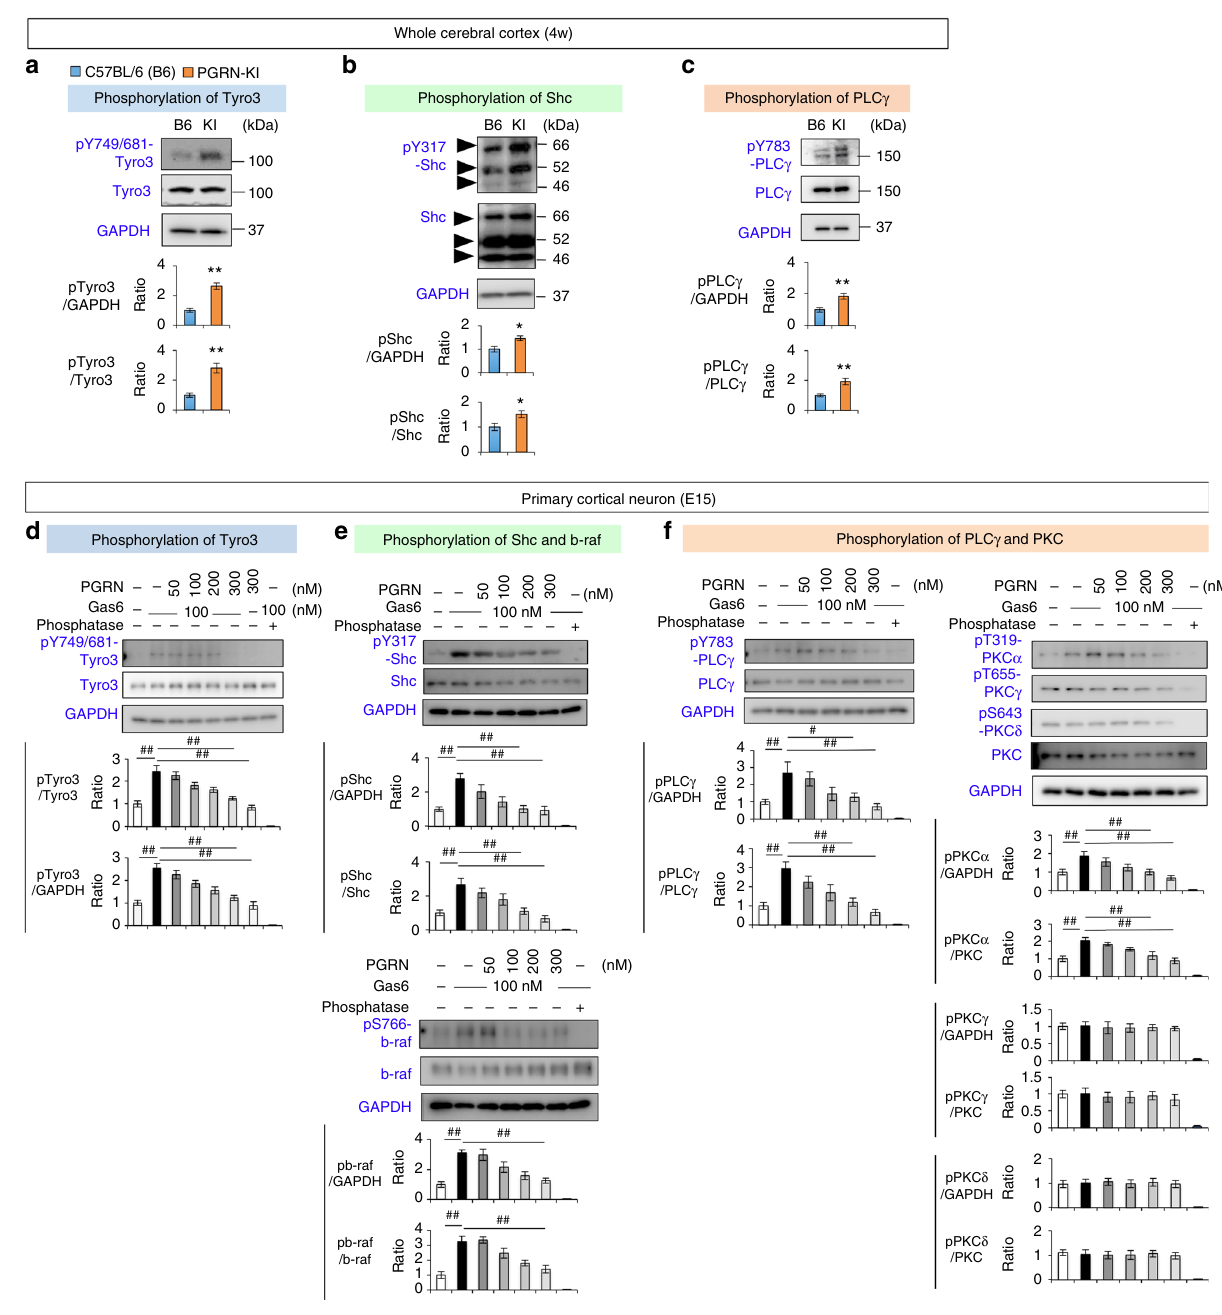
Fig. 3 PGRN inhibits downstream signals of Tyro3. a Western blot analyses show elevated phosphorylation of Tyro3 in the whole cerebral cortex sample prepared from PGRN-KI mice. Lower graphs show quantitation of pTyro3/GAPDH and pTyro3/Tyro3 ratios. * p < 0.05; ** p < 0.01 ( N = 6, Student ’ s t -test). Averages and s.e.m. are shown. b Western blot analyses show elevated phosphorylation of Shc was elevated in cerebral cortex of PGRN-KI mice. * p < 0.05; ** p < 0.01 ( N = 6, Student ’ s t -test). Averages and s.e.m. are shown. c Western blot analyses show elevated phosphorylation of PLC γ is increased in cerebral cortex of PGRN-KI mice. * p < 0.05; ** p < 0.01 ( N = 6, Student ’ s t -test). Averages and s.e.m. are shown. d Western blot analyses of Tyro3. Addition of Gas6 to culture medium increased phosphorylation of Tyro3 in cortical neurons (E15) at day 7 in primary culture, whereas co-addition of PGRN suppressed Gas6-induced phosphorylation of Tyro3. ## p < 0.01 ( N = 4, Dunnett ’ s test). Averages and s.e.m. are shown. e Western blot analyses of Shc and B-Raf. Gas6 increased phosphorylation of Shc and B-Raf in mouse primary cortical neurons at day 7, whereas PGRN suppressed the activation induced by Gas6. ## p < 0.01 ( N = 4, Dunnett ’ s test). Averages and s.e.m. are shown. f Western blot analyses of PLC γ and PKC α . Gas6 activated PLC γ and PKC α in mouse primary cortical neurons at day 7, whereas PGRN suppressed Gas6-induced activation of PKC α . PKC γ and PKC δ were not remarkably affected by Gas6. # p < 0.05; ## p < 0.01 ( N = 4, Dunnett ’ s test). Averages and s.e.m. are